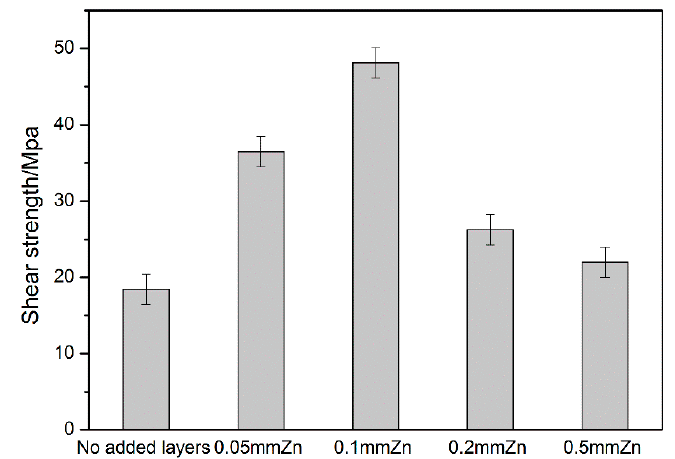
Figure 7. Vickers hardness of the welding joint with 0.1 mm Zn interlayer.